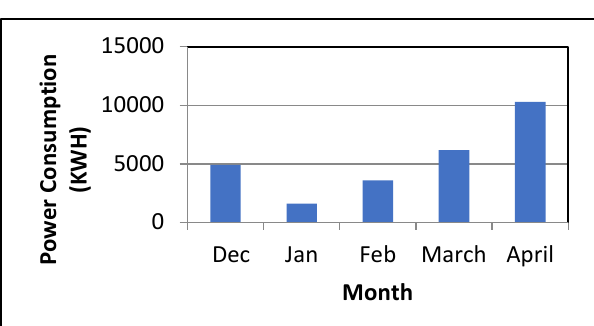
Figure 6 . Energy consumption Dec 2017-April 2018